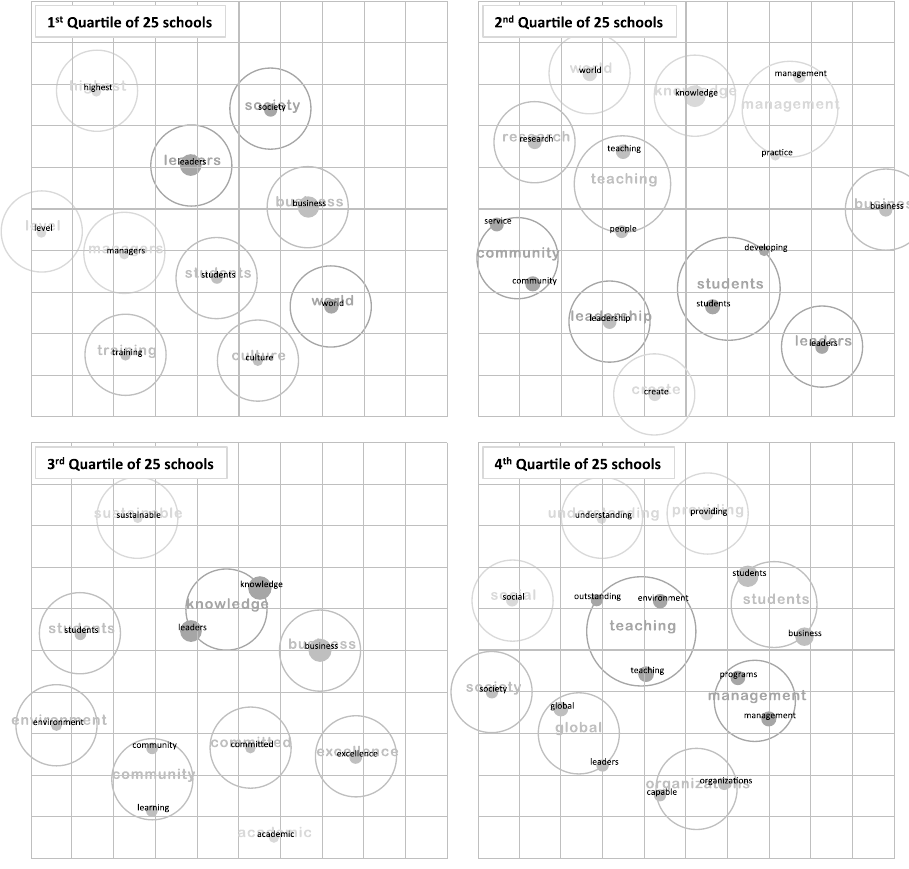
Figure 2: Leximancer™ maps across four